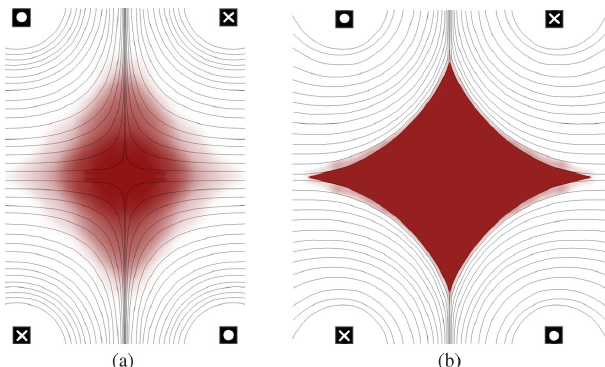
FIG. 1. Comparison of the predicted magnetic geometry at low β and at high β in a magnetic cusp configuration, with (a) low β and (b) high β . Note the convex nature of magnetic field lines. The red shading denotes plasma pressure. At high β (e.g., β ∼ 1 ), the strong plasma diamagnetism excludes the magnetic fields, which creates a sharp